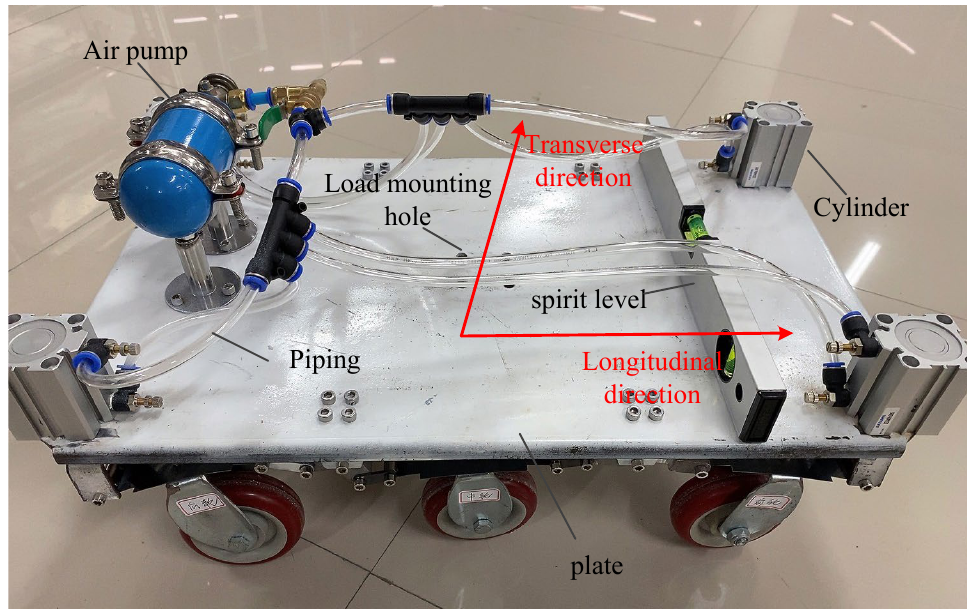
Figure 14. Optimized floating mobile chassis prototype.